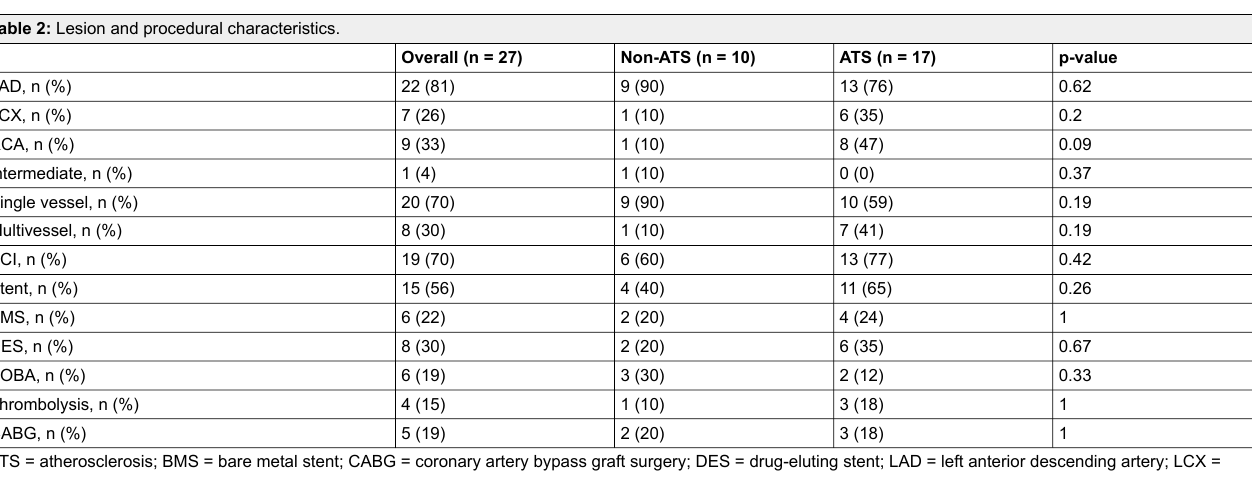
Table 2: Lesion and procedural characteristics.